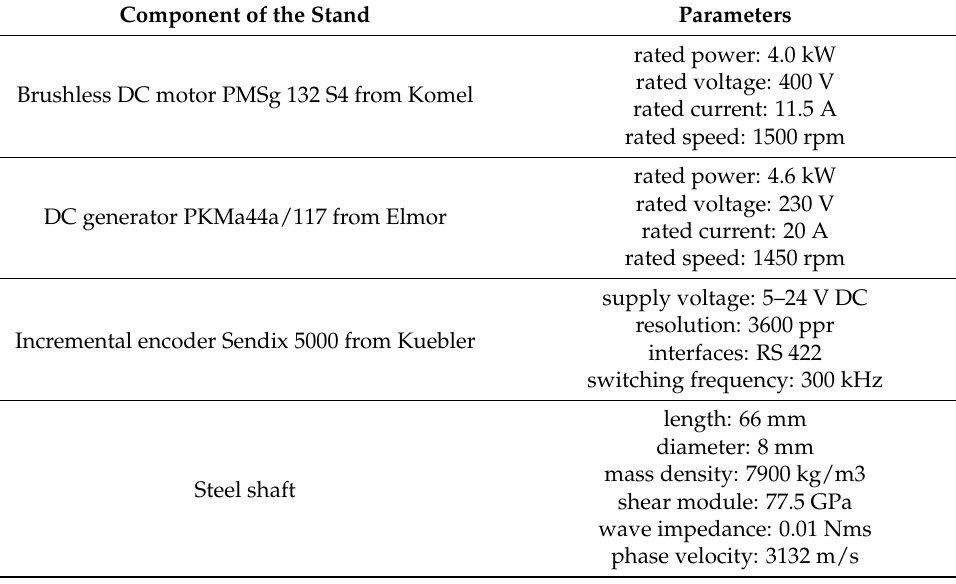
Table 1. Specification of the components of the stand presented in Figure 1. Component of the